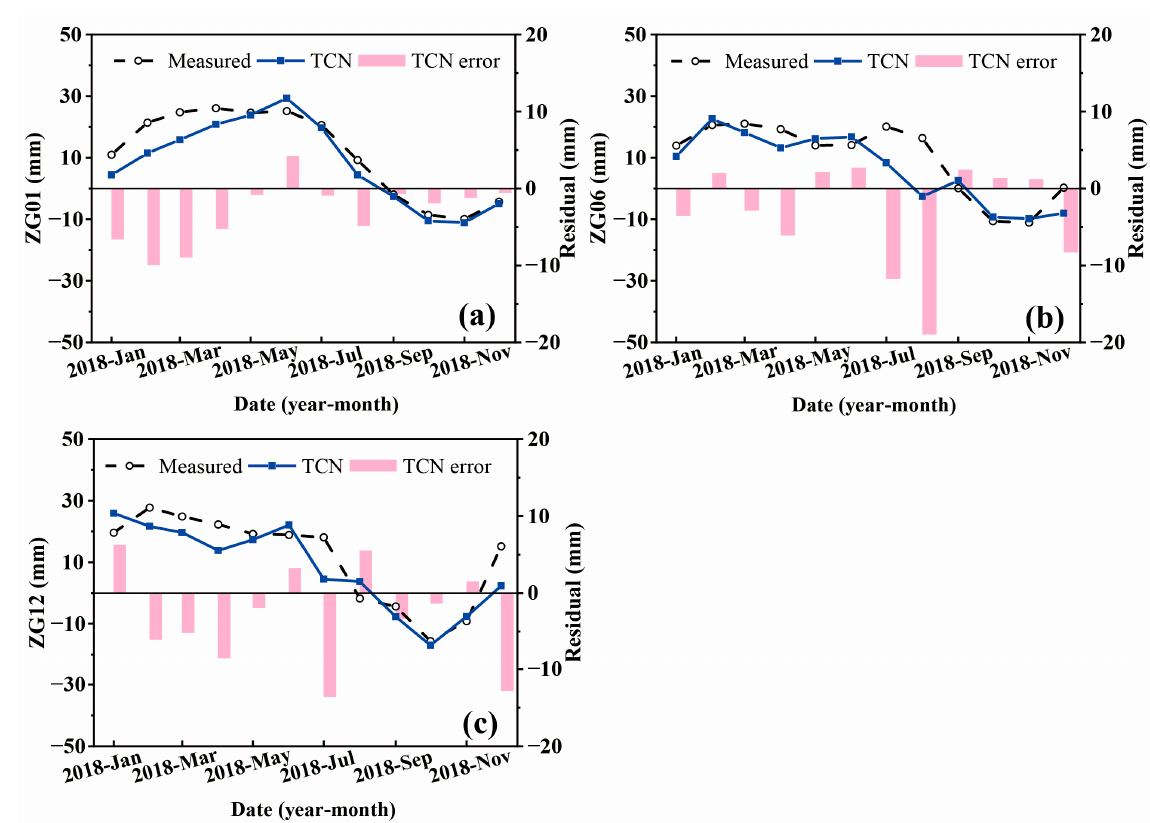
Figure 9. A comparison of the predicted and measured displacements: ( a ) ZG01, ( b ) ZG06, and ( c ) ZG12. Table 3. The errors of the predicted results of the TCN model.